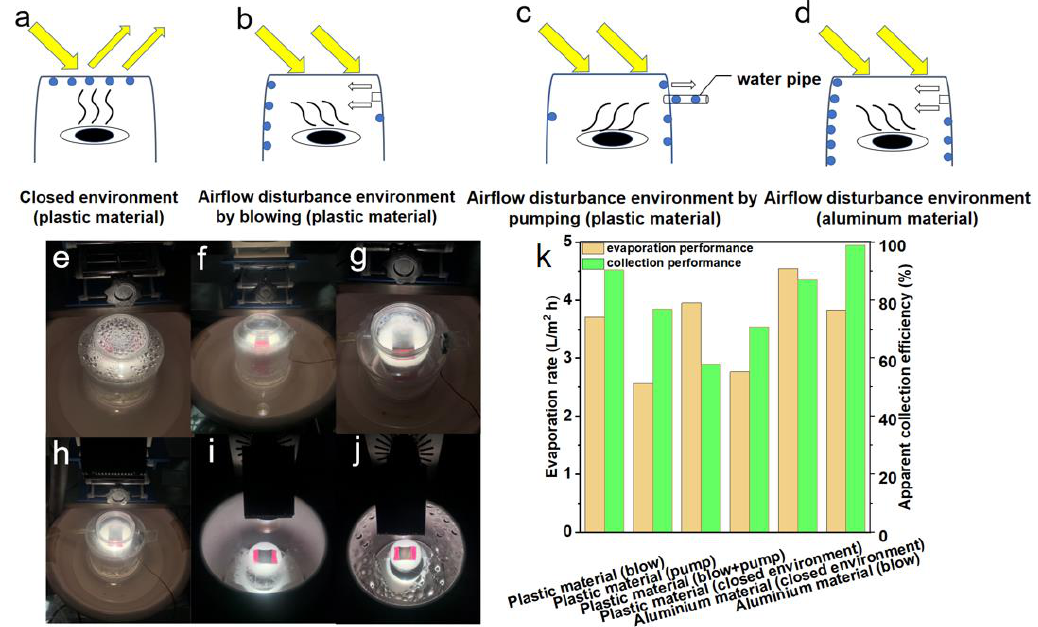
Figure 6. Scheme and solar vapor collection performance of different collection schemes. ( a ) Nor- mally closed environment with serious optical loss. ( b ) Airflow disturbance by blowing with a fan. ( c ) Airflow disturbance by pumping with an air pump. ( d ) Enhancing condensation by high thermal conductivity aluminum side wall. Photos of corresponding collection schemes: ( e ) plastic closed environment, ( f ) blow, ( g ) pump, ( h ) blow + pump, ( i ) aluminum side wall, and ( j ) aluminum side wall with blow. ( k ) Solar evaporation rate and apparent collection efficiency of different collection schemes.